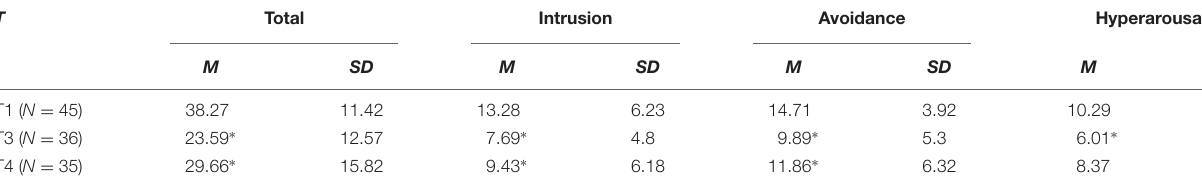
TABLE 2 | Impact of Event Scale-Revised (IES-R) scores.